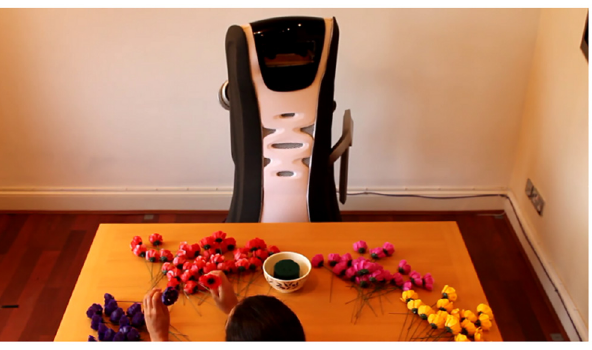
Fig 2. Final experimental setup showing the “ over-the-shoulder ” perspective.